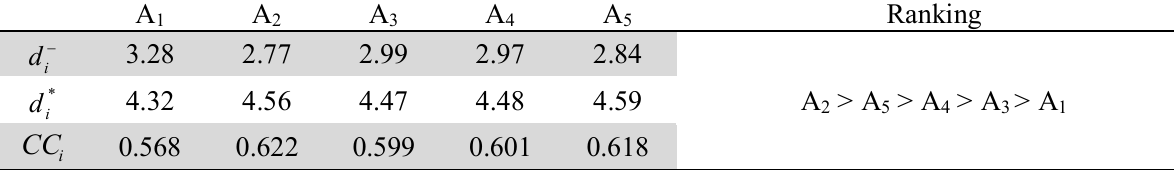
) and ranking of the five i